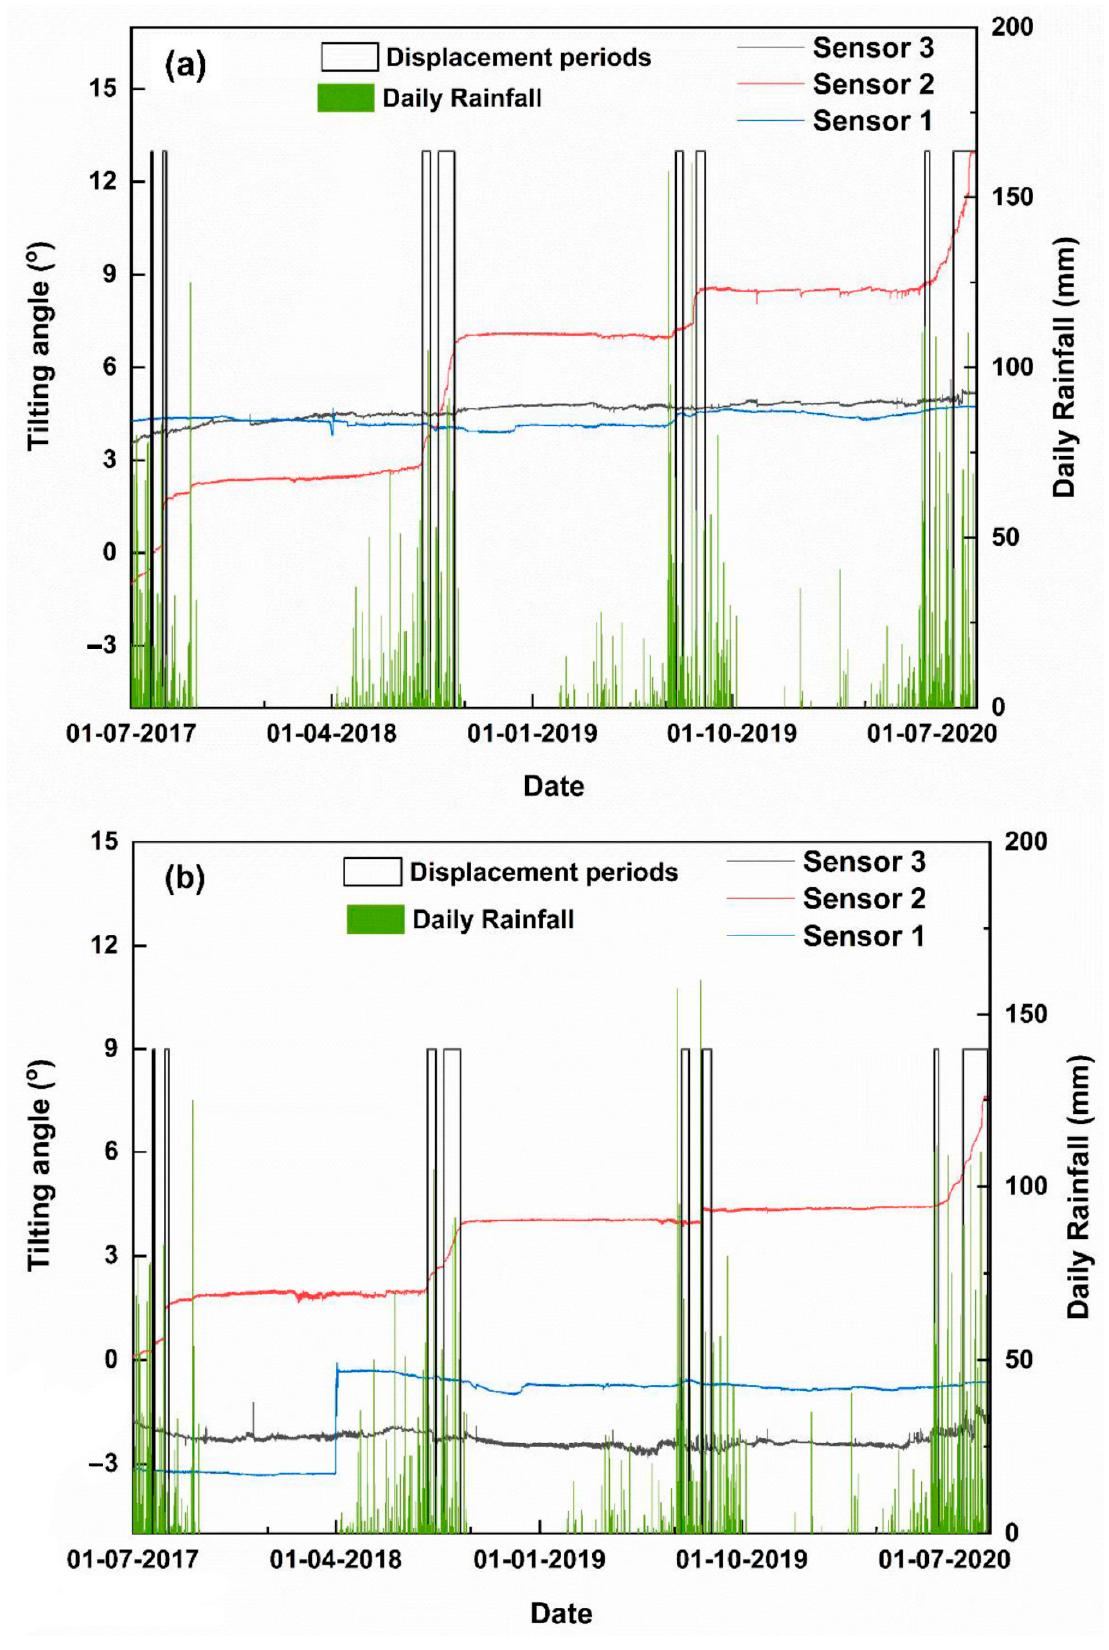
Figure 7. The recordings from sensors along with daily rainfall data and displacement periods ( a ) tilting angle in the direction parallel to slope, and ( b ) tilting angle in the direction perpendicular to slope.